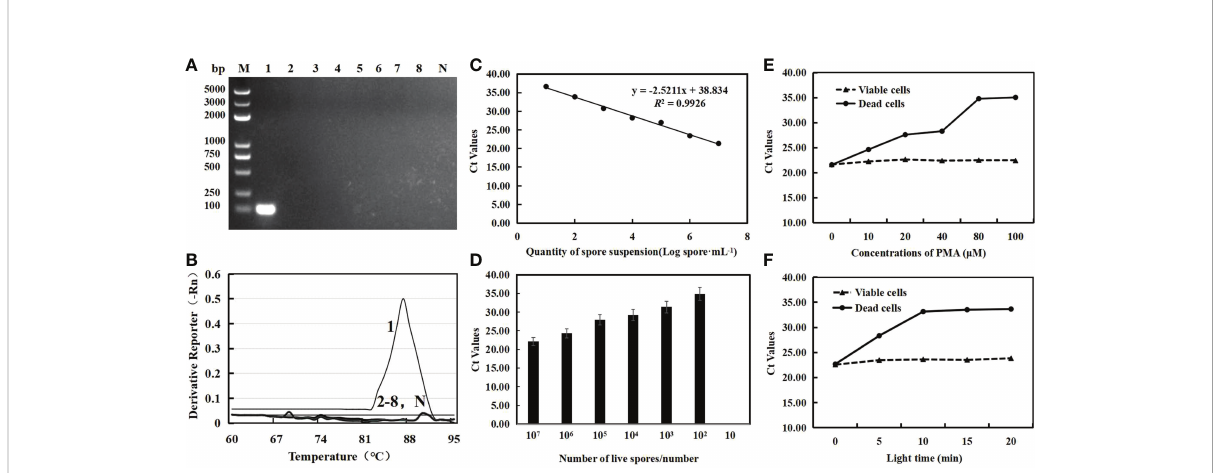
FIGURE 1 Speci fi c detection for primer CC-F3/CC-R3 where M is a ladder (100 bp) DNA ladder (A) and the melting curve of qPCR for gradient dilution genome DNA of C . cassiicola (B) ; lane 1 is C . cassiicola samples, lane 2 is Pseudoperonospora cubensis samples, lane 3 is Sphaerotheca cucurbitae samples, lane 4 is Pseudomonas syringae samples, lane 5 is Fusarium oxysporum samples, lane 6 is Alternaria cucumerina samples, lane 7 is Cladosporium cucumerinum samples, lane 8 is Colletotrichum orbiculare samples, and lane N is ddH 2 O. PMA-qPCR standard curve (C) and sensitivity analysis (D) ; Effects of PMA concentrations (E) and light time (F) on the ampli fi cation of DNA from viable and dead C. cassiicola spores at 10 7 spore·mL − 1 . Ct, cycle